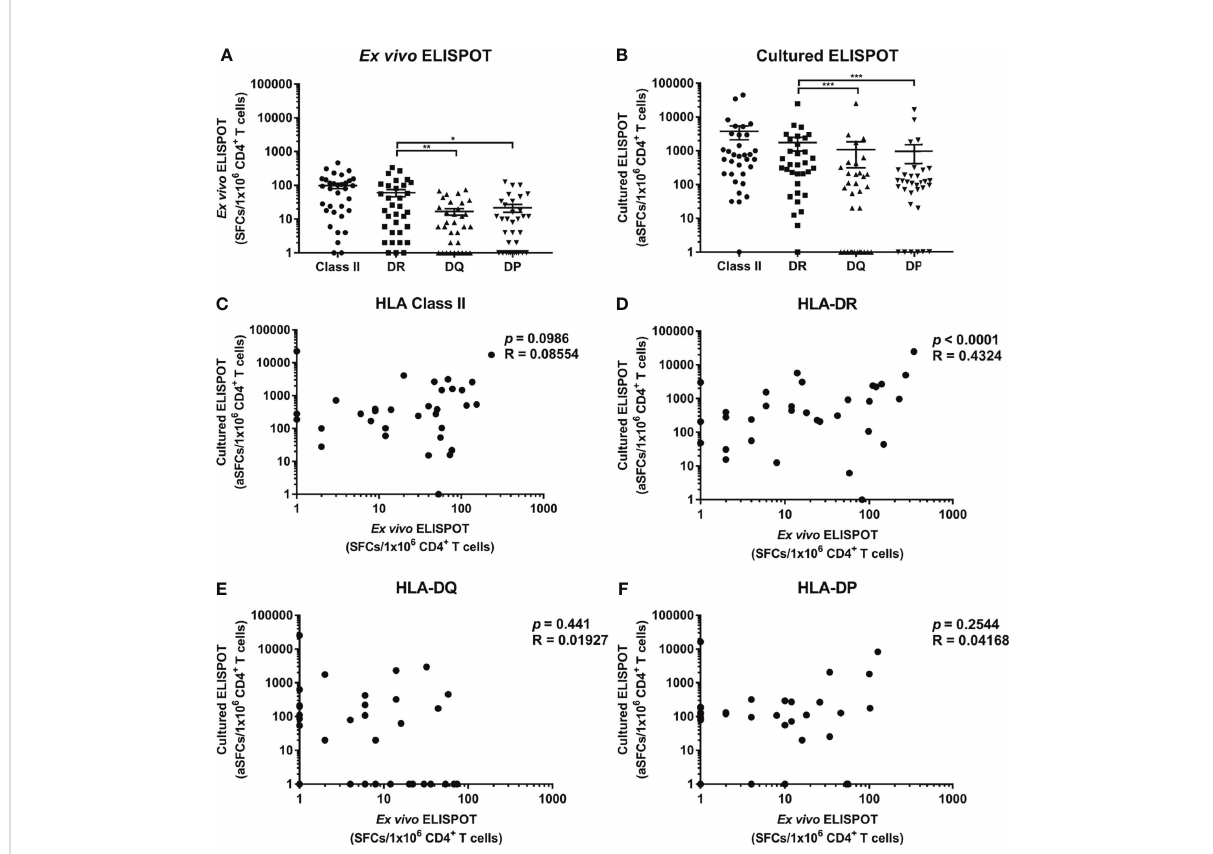
FIGURE 2 Frequencies of CD4 + T cells speci fi c for M. tuberculosis antigens restricted by HLA class II loci and correlation between ex vivo and cultured ELISPOT. (A) Ex vivo ELISPOT, (B) Cultured ELISPOT. Statistical analysis was performed using Wilcoxon test. * p < 0.05, ** p < 0.01, *** p < 0.001. Error bars present mean ± standard error of the mean. The frequencies M. tuberculosis -speci fi c CD4 + T cells were adjusted to the frequency per 1×10 6 CD4 + cells in peripheral blood to compare ex vivo and cultured ELISPOT. Correlation between ex vivo and cultured ELISPOT of HLA class II (C) which is the sum of the responses by all HLA class II allotypes, and of each HLA-DR (D) , -DQ (E) and -DP (F)